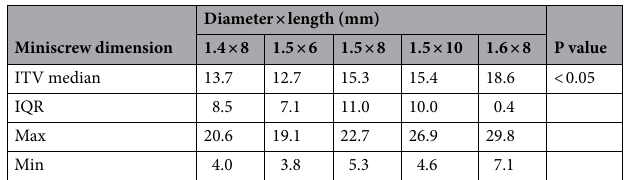
Table 1. ITVs based on different orthodontic miniscrew dimensions. IQR interquartile range, Max maximum, Min minimum.